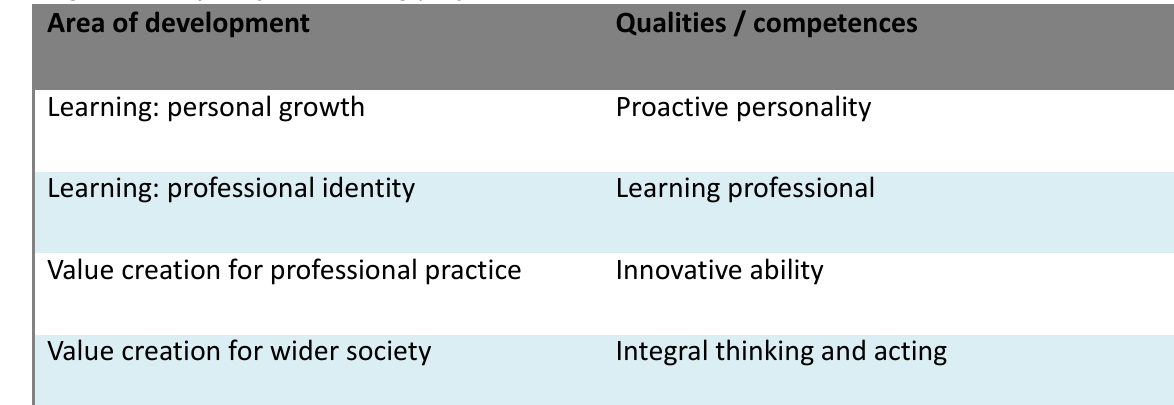
Figure 1: Profile of the leading professional in value creation Area of development Qualities /